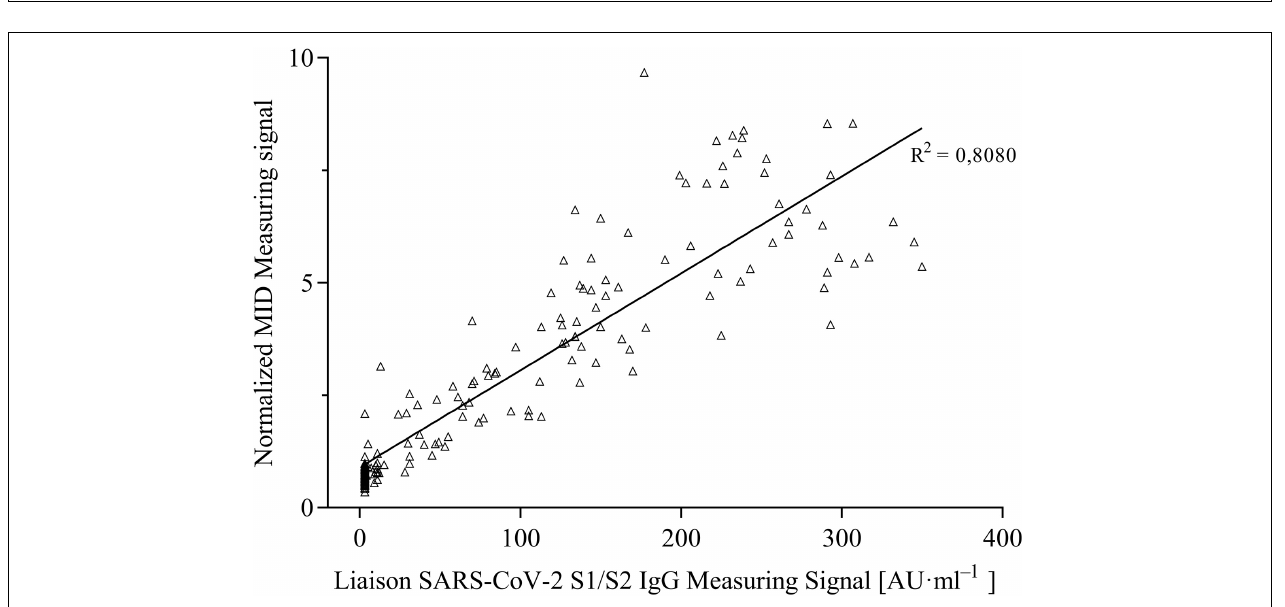
FIGURE 6 | Correlation of measuring signals of certified DiaSorin Liaison SARS-CoV-2 S1/S2 IgG assay and developed portable magnetic immunodetection assay ( n = 1).